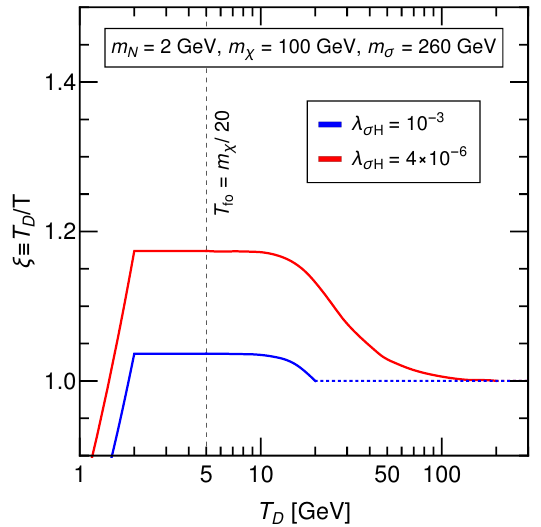
Figure 8 . Evolution of the ratio of the dark sector and SM temperatures, ξ ≡ T D /T , for two repre- sentative values of the Higgs portal coupling λ in Model A2b. The masses have been fixed to the σH values used in figure 7. For λ = 10 − 3 (blue line), N is relativistic at the time of kinetic decou- σH pling, T 20 GeV, and down to the DM freeze-out at T 5 GeV. For λ = 4 × 10 − 6 (red line), D ≈ D ≈ σH both χ and N are relativistic at kinetic decoupling, T 200 GeV, but only N is at the D ≈